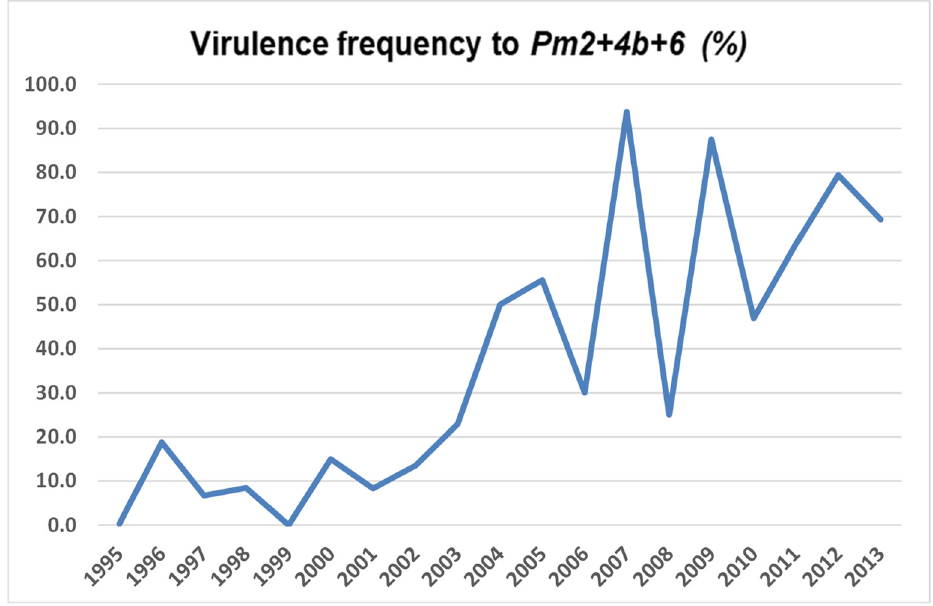
Figure 1. Virulence frequency to the gene combination Pm2+4b+6 during 1995–2013. Table 6. Distance between powdery mildew populations. Populations Common